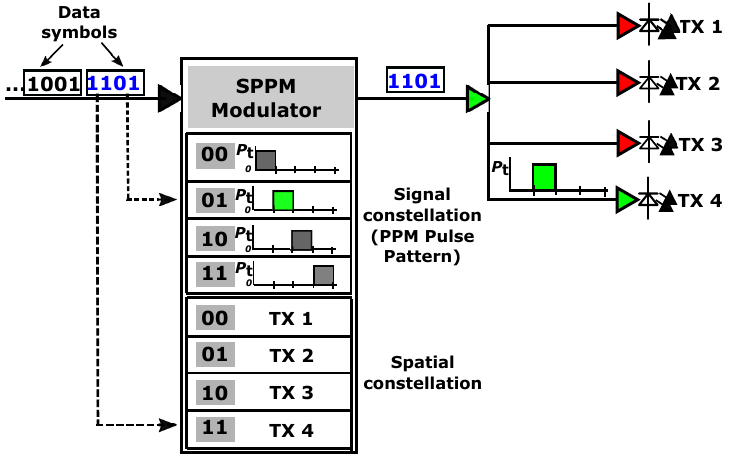
Figure 1. Illustration of spatial pulse position modulation (SPPM) encoding using N t = 4, L =